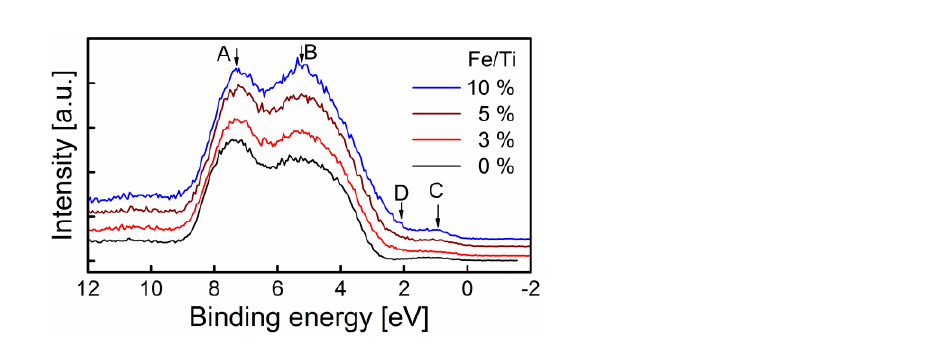
Figure 13. Magnetization (M-H) curves for iron-doped TiO 2 nanoparticles compared to pure TiO 2 measured under an external magnetic field (H), from −30 to 30 kOe at temperatures of ( a ) 5 K and ( b ) 300 K. 2.5. Optical Properties The UV–vis absorption spectroscopy was adopted to determine light absorption from iron-free and iron-doped TiO 2 nanoparticles. The spectra are shown in Figure 14.